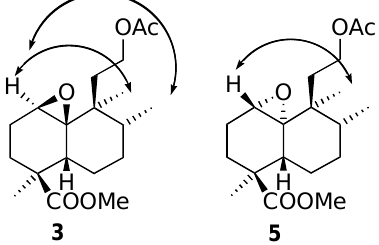
Figure 3. nOe experiments for determination of the configurations of epoxides 3 and 5